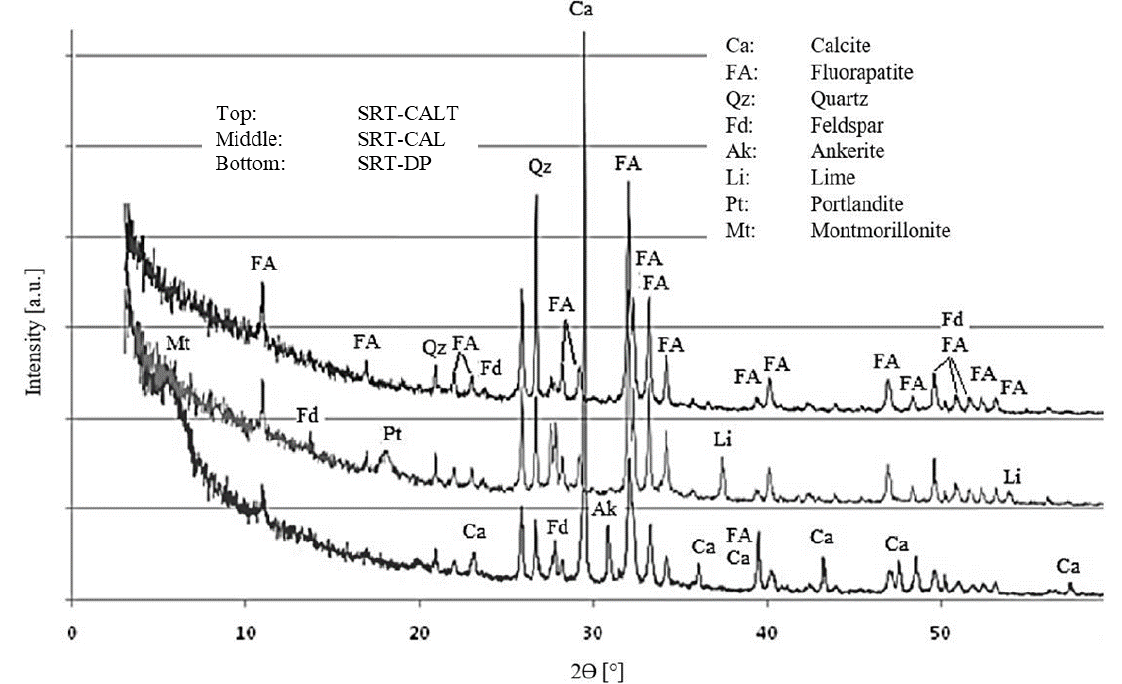
Figure 11. XRD patterns of the calcined and treated (SRT-CALT), calcined (SRT-CAL), as well as untreated (SRT-DP) Sra Ouertane (layer A1) phosphate rock.